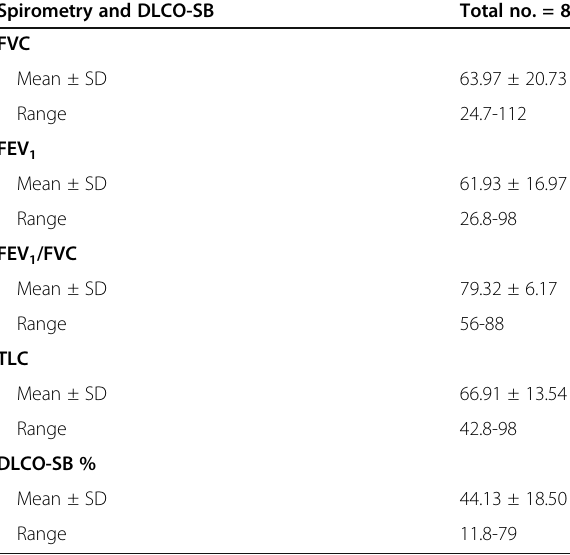
Table 3 Spirometry and diffusion parameters among